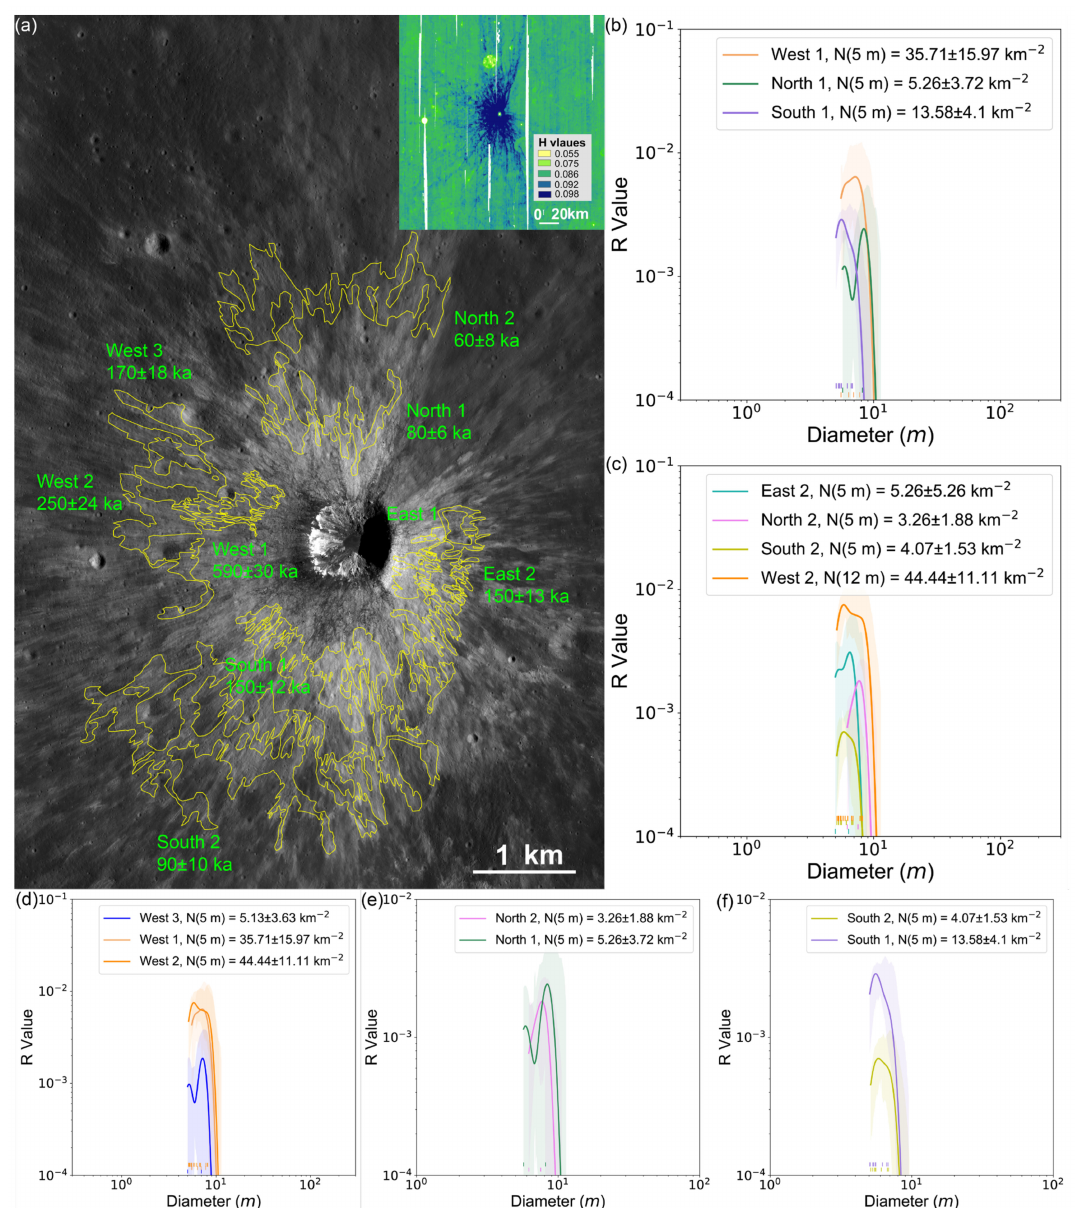
Figure 7. Size-frequency distribution of crater populations on the ejecta deposits of a cold spot crater ( D = 898 m), which is centered at 90.76 ◦ E, 5.39 ◦ S. ( a ) This crater is produced by an oblique impact coming from the northeast, but the impactor trajectory was less shallow compared to that shown in Figure 6a. Solar illumination is from the right, and north is up. The yellow areas show the locations of the nine counting areas that are aligned with their model ages. IDs of data used in this figure are compiled in the Supplementary Materials. ( b – f ) compare crater SFDs on the three counting areas on the inner ejecta ( b ), the four areas on the outer ejecta ( c ), three areas on the western ejecta ( d ), two areas on the northern ejecta ( e ), and two areas on the southern ejecta ( f